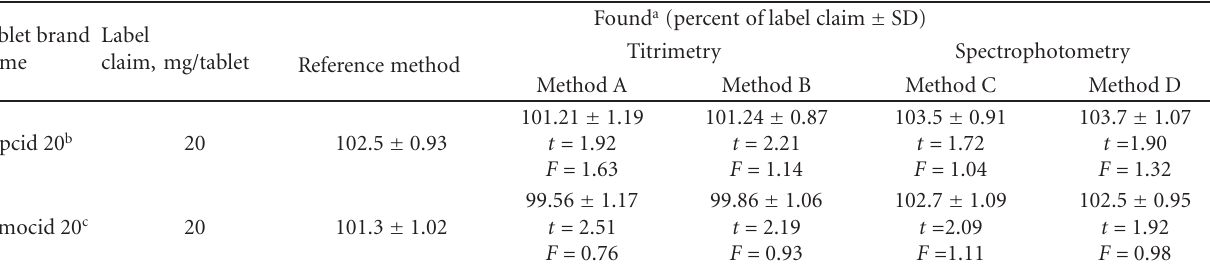
Table 5: Results of analysis of tablets by the proposed methods.